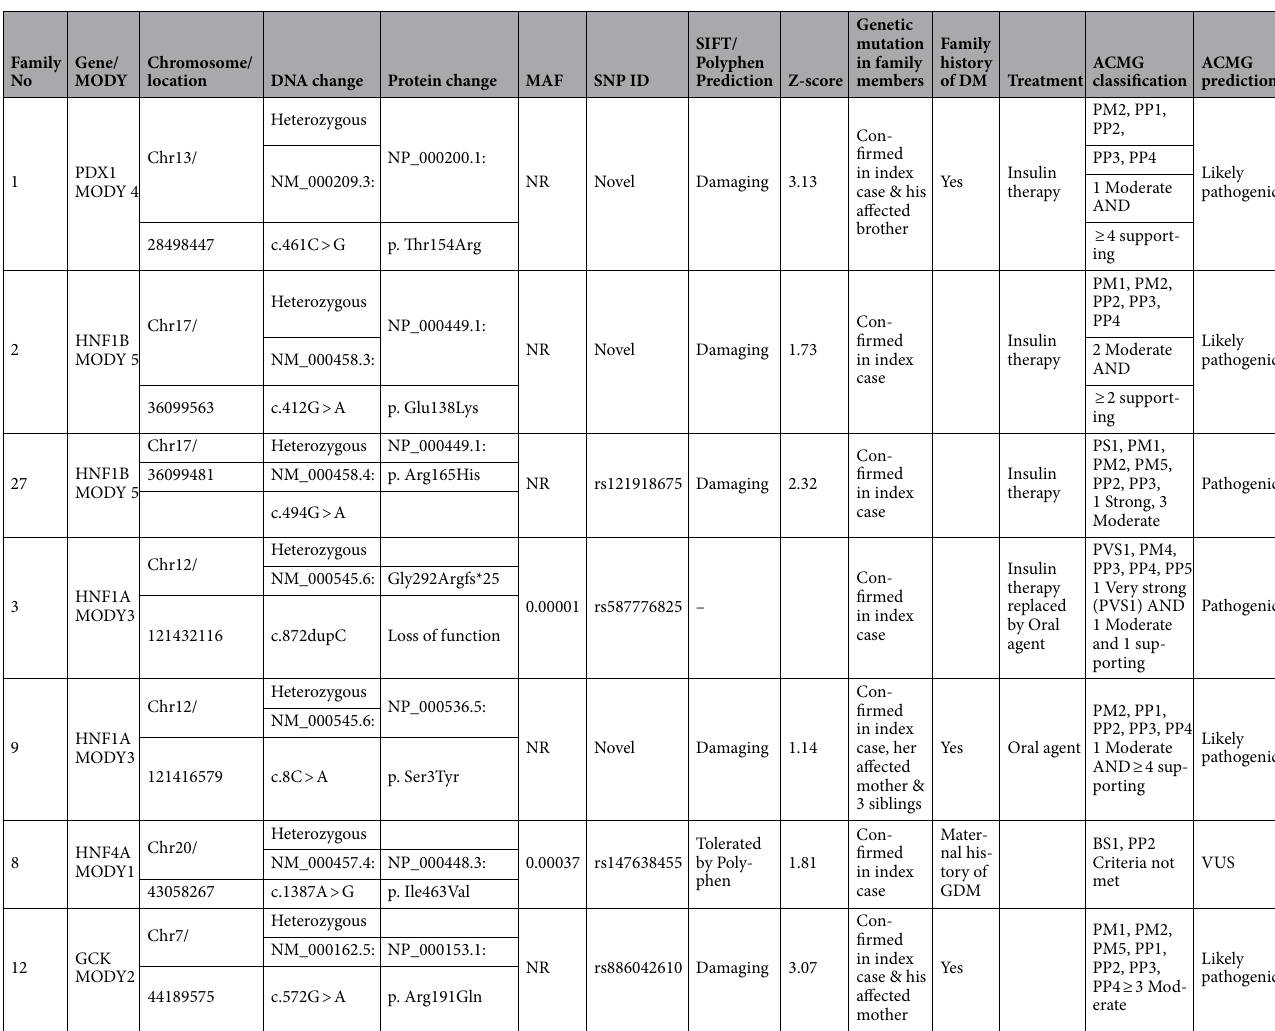
Table 2. Genetic variants identified in seven families with MODY. MAF, Minor allele frequency; VUS, Variant of unknown significance, *Z-score indicates a gene’s intolerance to missense variants. Z-score >1 indicates a low rate of benign missense change of the gene or increased intolerance/constraint to variation. NR denotes Not Reported in Public database. ACMG classification was carried out following the recommendations